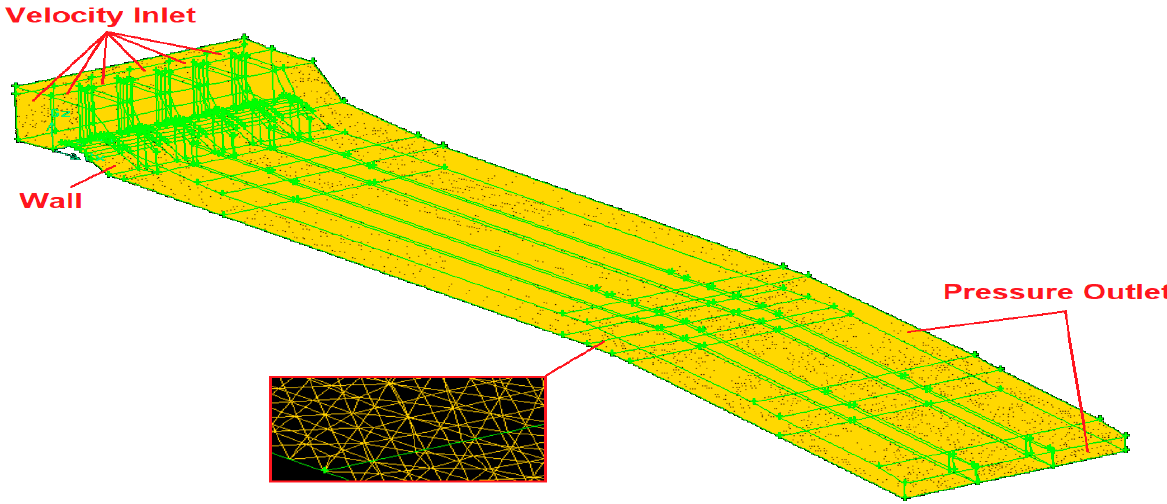
Figure 6. Mesh in the three-dimensional spillway model and boundary conditions.